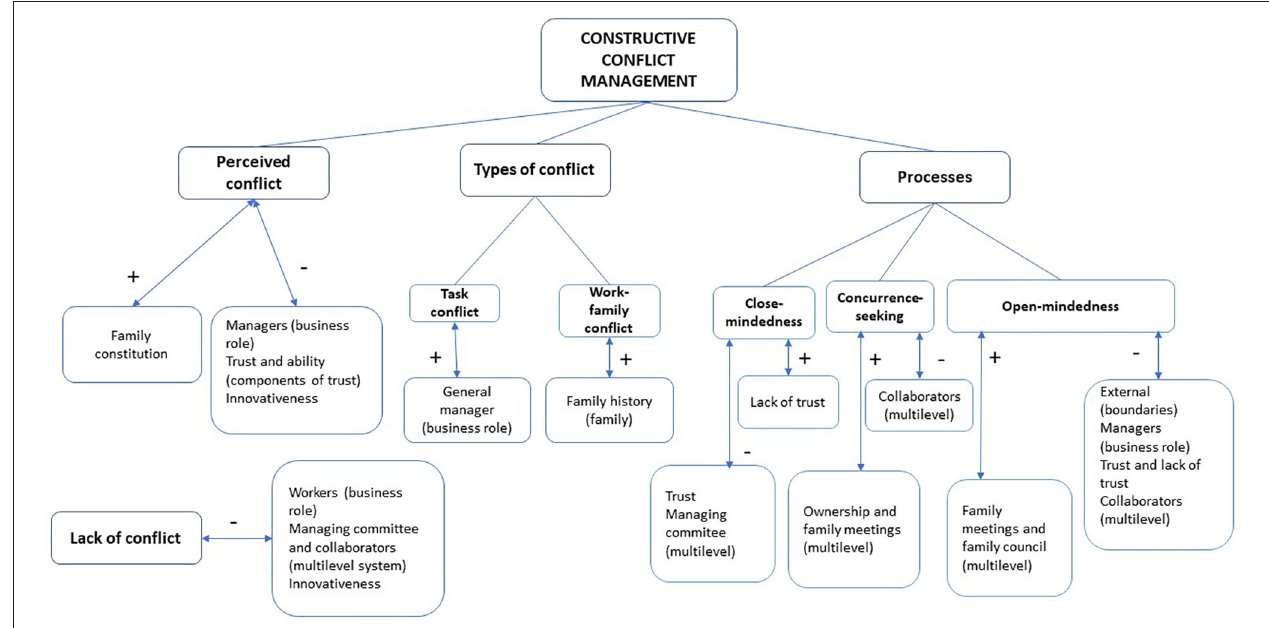
FIGURE 6 | Structure of significant associative relationships of constructive conflict management dimension (